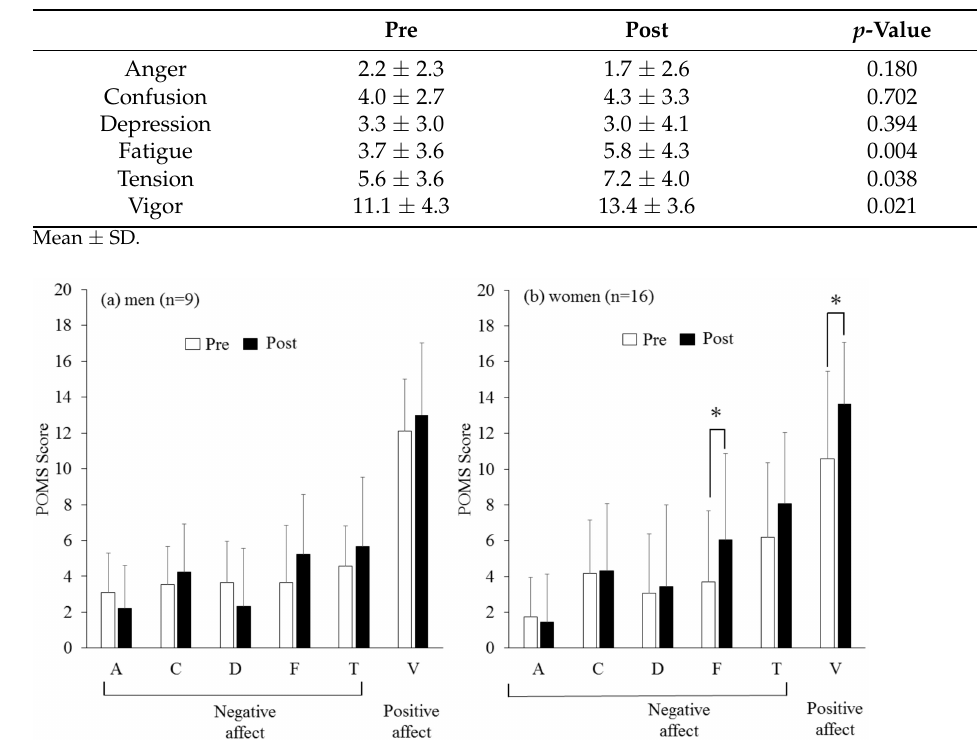
Figure 3. ( a,b ) Changes in POMS before and after esports games in men (( a ), n = 9) and women (( b ), n = 16). *: p < 0.05 vs. pre. Positive affect increased significantly in females ( p = 0.022; Figure 3b), but not in males ( p = 0.438, Figure 3a). Negative affect did not change in males ( p = 0.953) or females